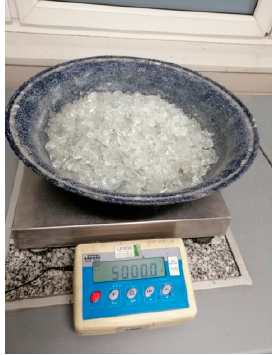
Figure 3. Glass cullet. Analytical sample.